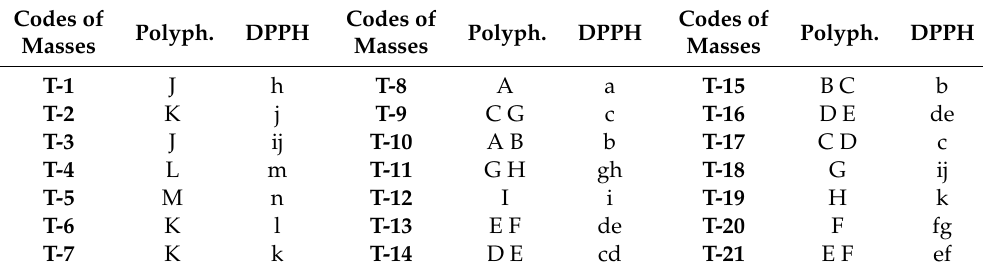
Table 5. Results of statistical analysis of polyphenols content and antiradical activity of all analyzed milk chocolate masses (code explanation in Table